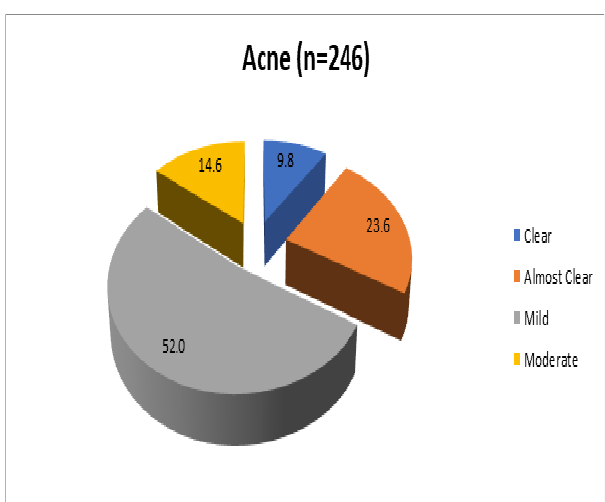
Figure-I: Frequency of Acne Vulgaris Patients according to Comprehensive Acne Severity Scale